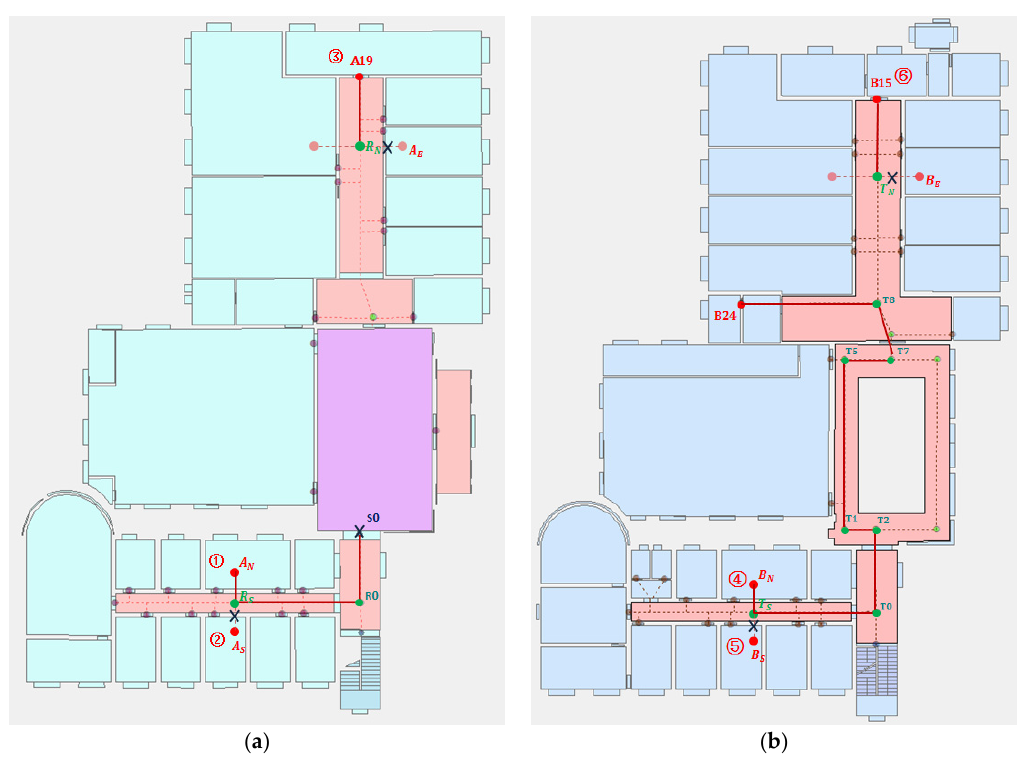
Figure 8. Semantic matching process. ( a ) The first floor; ( b ) The second floor.